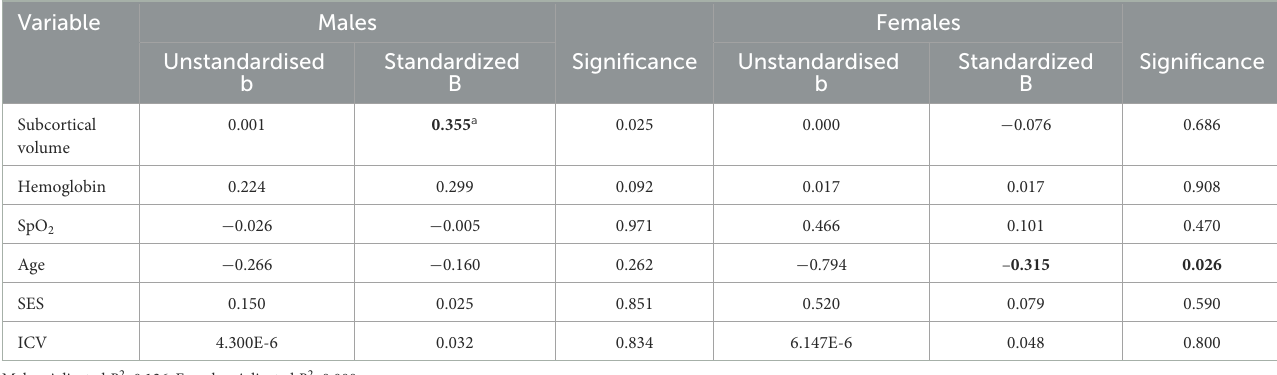
TABLE 7 Regression coefficients for working memory index in male and female patients.